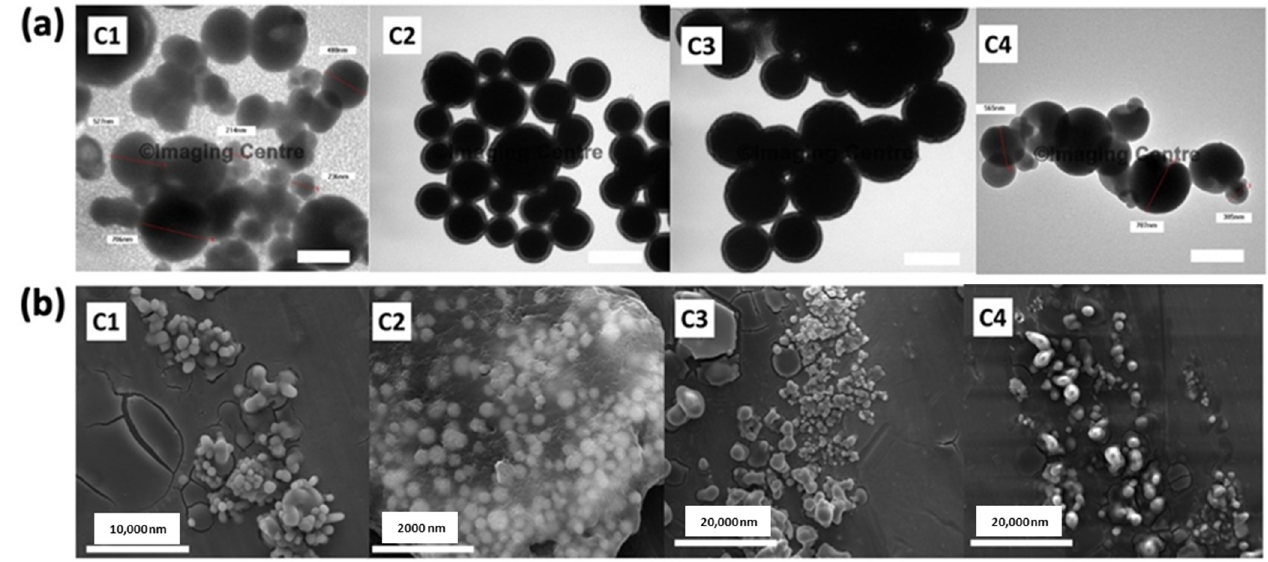
Figure 3. ( a ) TEM image of L-Dopa loaded chitosan nanoparticles for formulation C1–C4. Scale bar: 500,000 nm ( b ) SEM image of L-Dopa loaded chitosan nanoparticles for formulation C1–C4. Scale bar for respective image is embedded in the image.